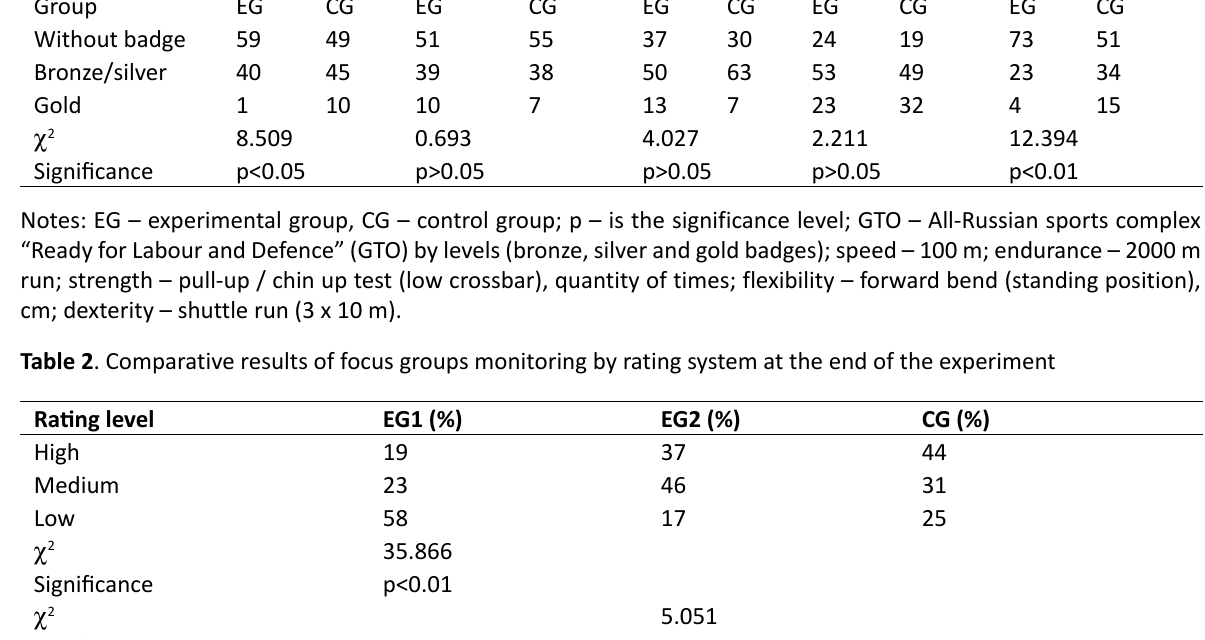
Table 1 . The results of physical qualities testing of the EG and the CG in percentage GTO badge